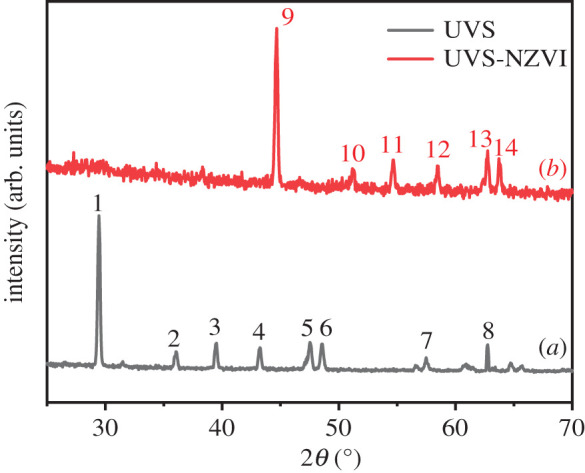
XRD pattern of UVS (a) and UVS-NZVI (b). 1–3, 5, 7, 8, 12, 13 = calcite-type CaCO3; 4, 6 = aragonite-type CaCO3; 9, 10 = Fe0; 11 = Fe2O3; 14 = Fe(OH)3.